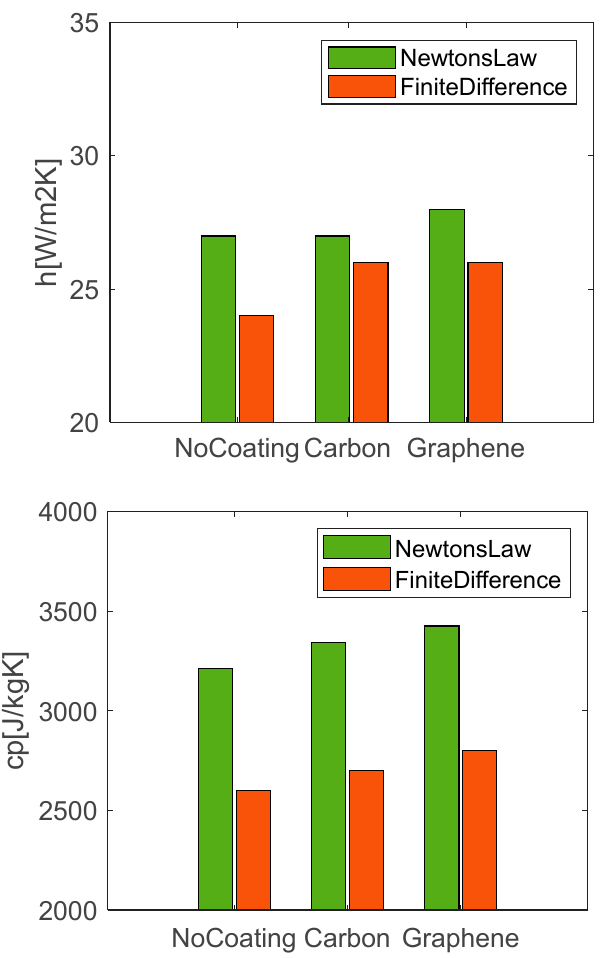
Figure 11. Estimated values of h and c p with Newton’s law and finite-differences method for different coating at discharge rate 1C.